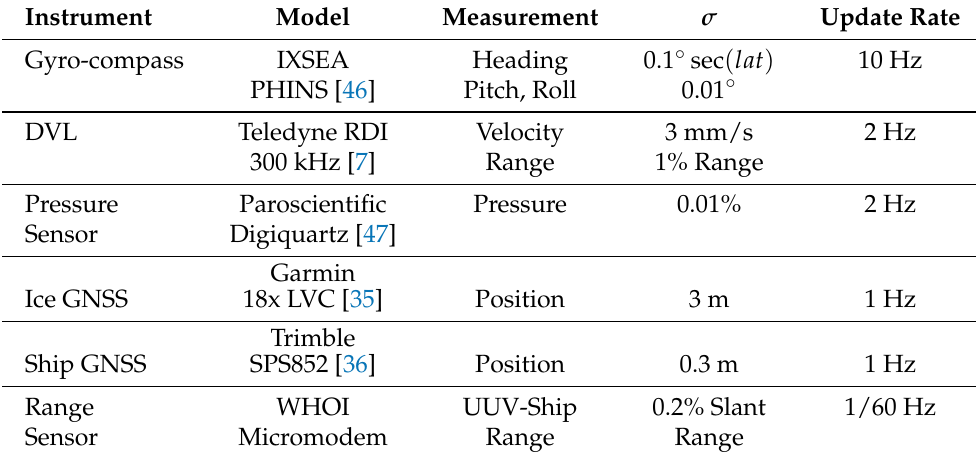
Table 1. Simulated sensor update rates and noise